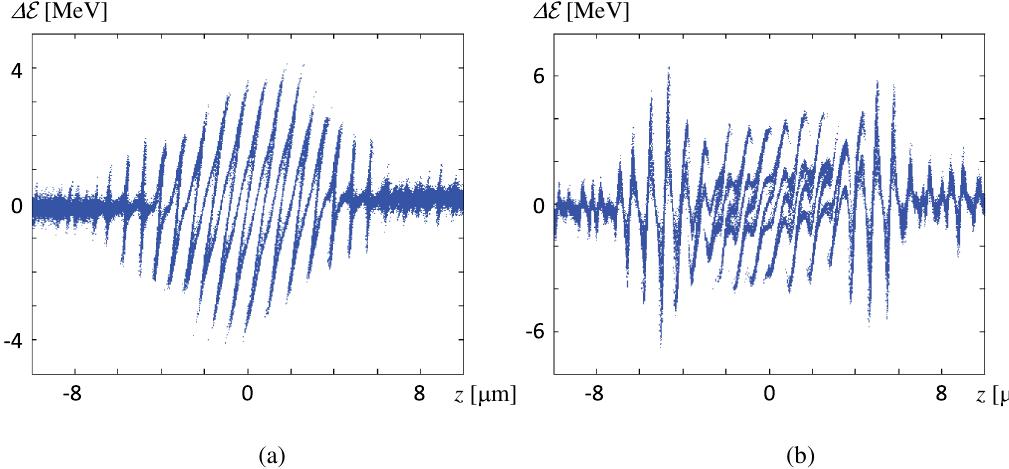
FIG. 10. Application A: longitudinal phase space (a) direct after chicane 3 and (b) 15 m behind, for 30 fs (FWHM) laser modulation, calculated with one million macro-particles, by